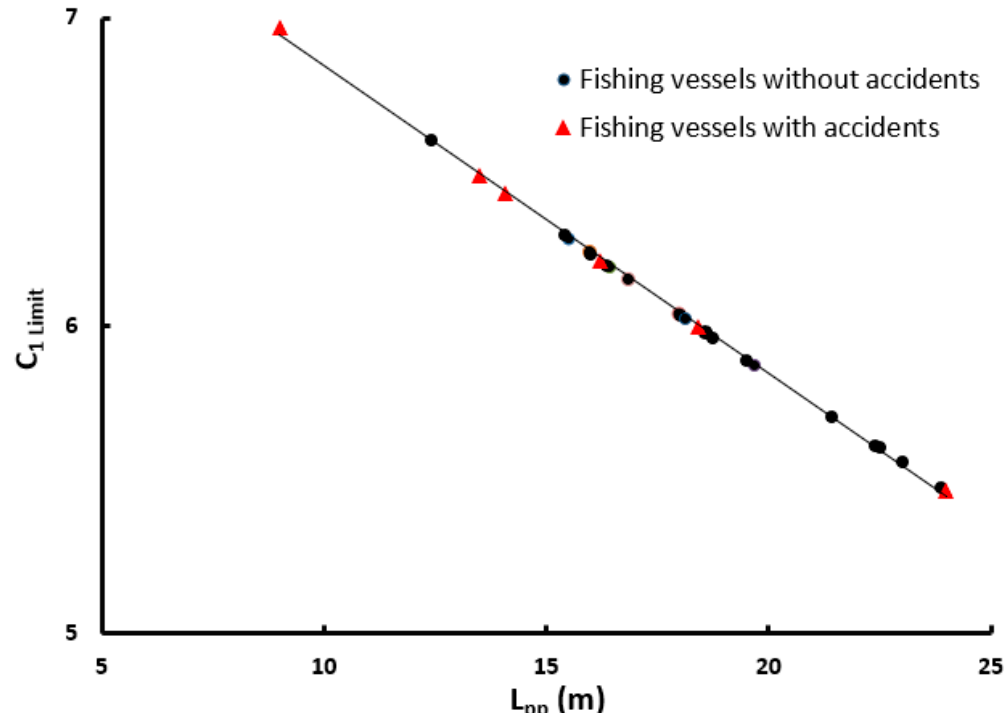
Figure 3. The limiting values of C 1 coefficient of the analyzed vessels with and without accidents as a function of vessel length ( L pp ).